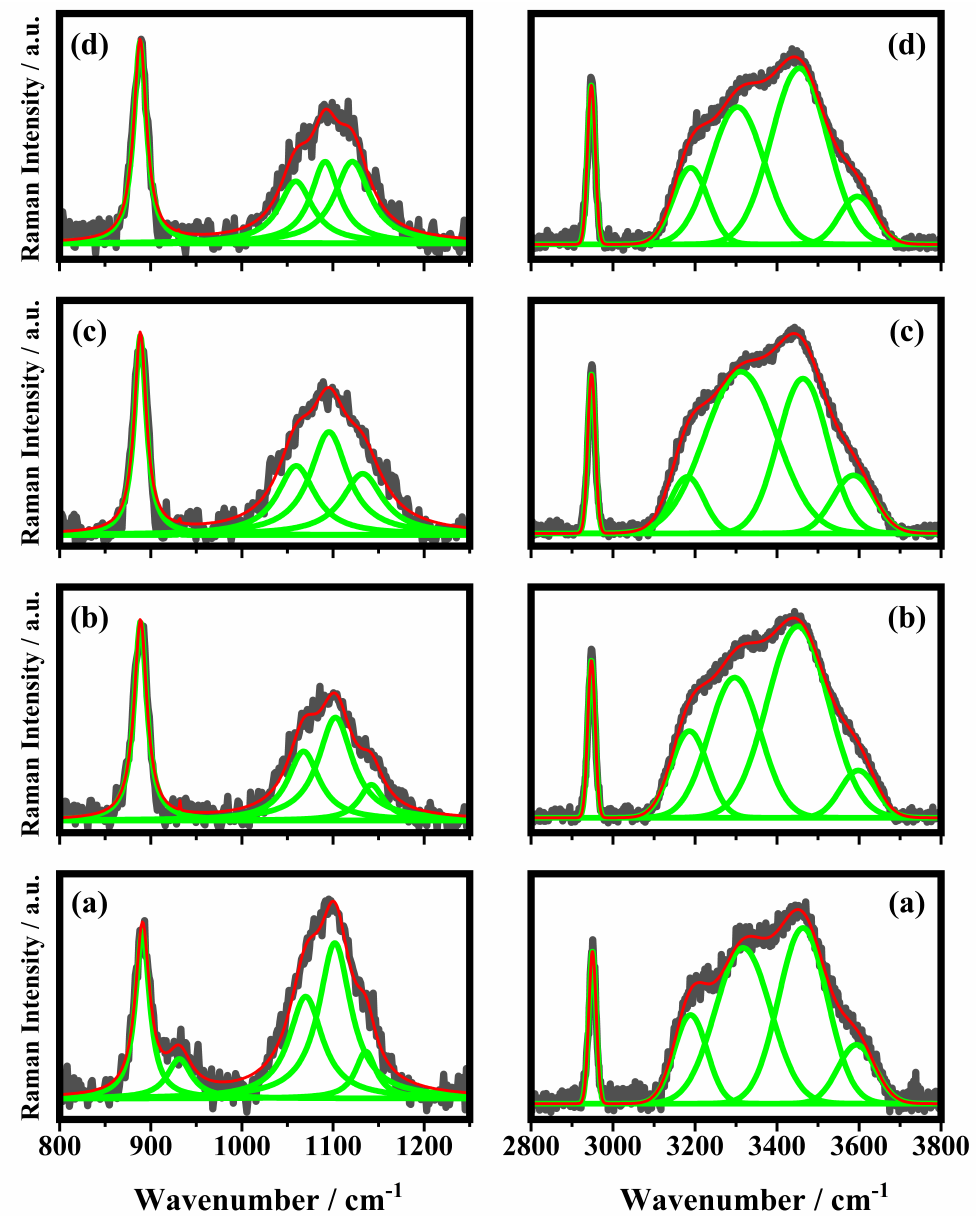
Figure 5. Fitting procedure in ranges between 800 and 1250 cm − 1 (on the left) and between 2800 and 3800 cm − 1 (on the right) of the Raman bands of 10% v / v acetic acid solution deposited on ( a ) GGPE 0 (glass substrate/GNPs), ( b ) GGPE 3 (glass substrate/GNPs/3 layers of PE material), ( c ) GGPE 11 (glass substrate/GNPs/11 layers of PE material), and ( d ) GGPE 21 (glass substrate/GNPs/21 layer of PE material). The grey line is the experimental spectra, the green lines are single fitting curves, and the red line is the total fitting